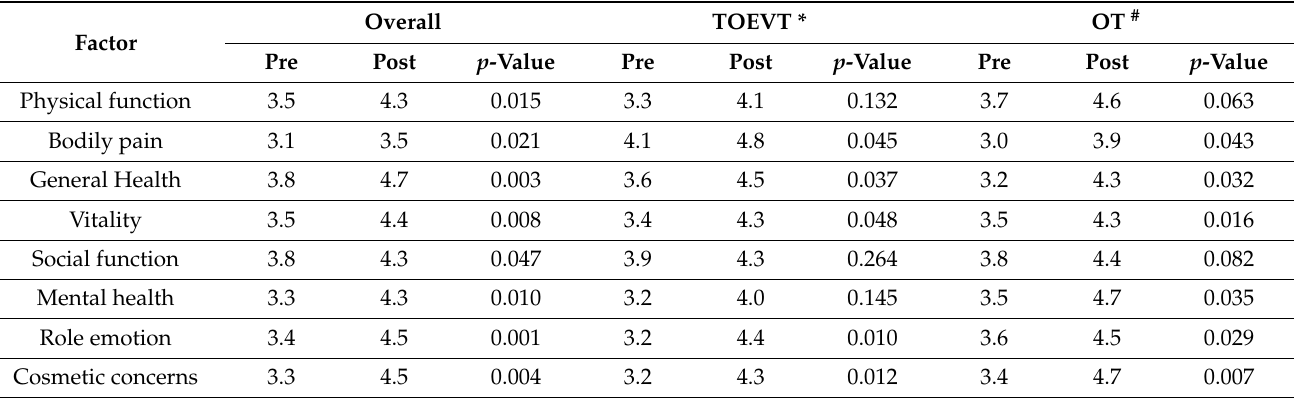
Table 7. A comparison of the quality of life pre-post transoral endoscopic vestibular and open thyroidectomy after propensity score matching ( n = 34).